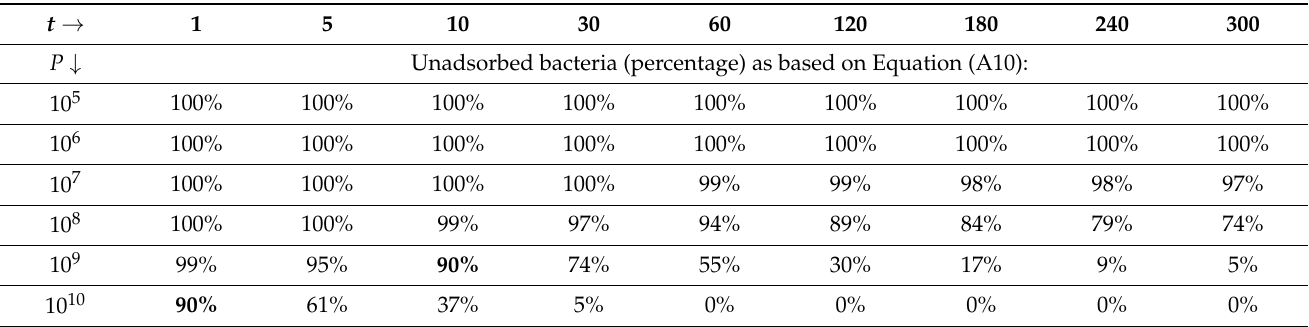
Table A4. Percentage of bacteria remaining unadsorbed as functions of phage titers ( P ) and adsorption intervals ( t ), k = 2.5 × 10 − 11 mL − 1 min − 1